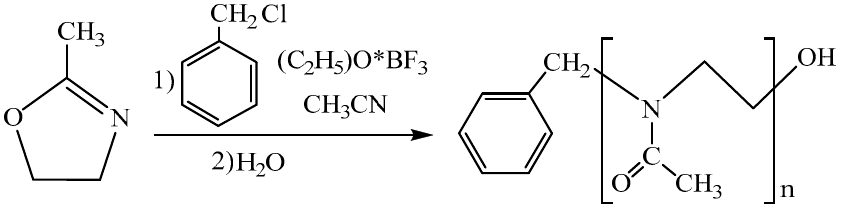
Figure 1. 2-methyl-2-oxazoline polymerization scheme.